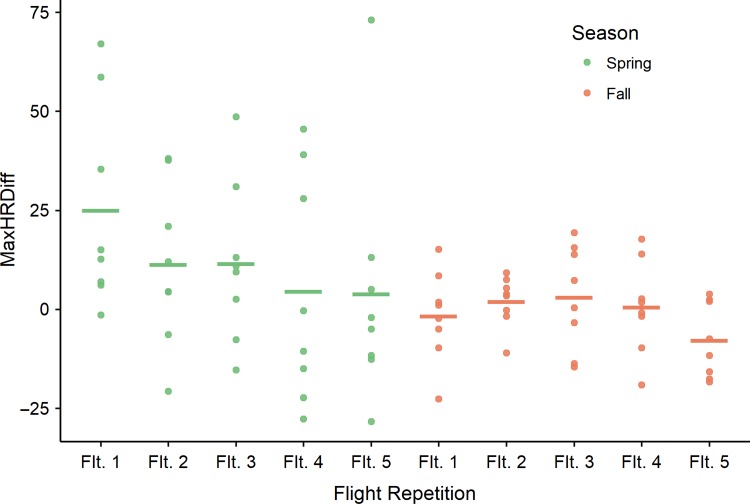
Example of diminishing cardiac responses (difference from baseline [95% upper CI of HR 30-min prior to first UAS flight of each day]) of one of five captive American black bears to repeated UAS flights. Bears were exposed to 80 flights: five times per day on eight flight days in both spring and fall. Each point is the HR response to one of these eight flights (bars represent means) grouped by the first to fifth flight of each day for each season separately.